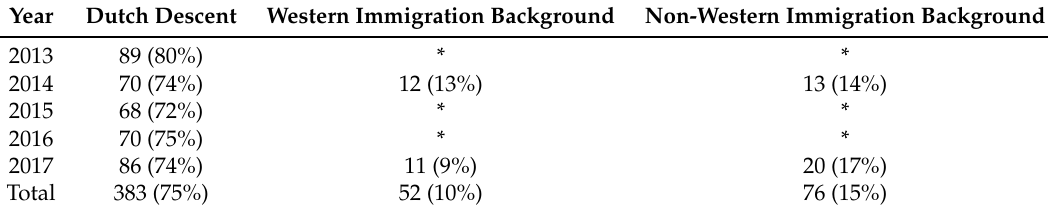
Table 6. Number of suicides among youths under 23 of Dutch descent, youths with a western migration background and youths with a non-western immigration background (percentage of total in year in brackets).